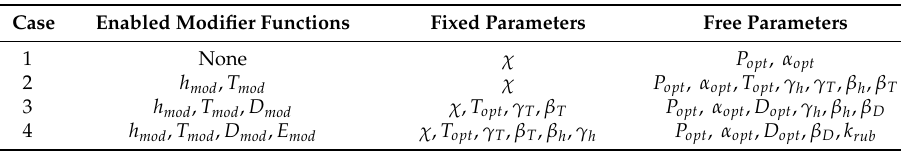
Figure 3. Schematic diagram of methods including test functions; GPP = gross primary productivity, PAR = photosynthetically active radiation. Table 1. Overview of the different model inversion cases, the down-regulation mechanisms investigated and their fixed and free parameters.